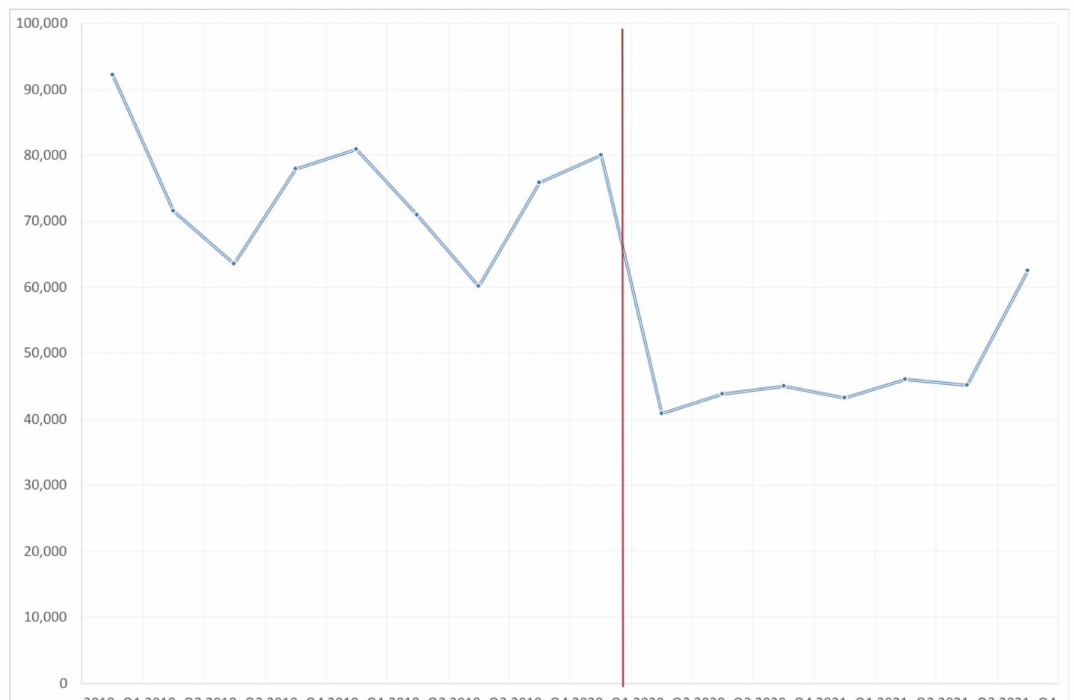
Figure 1. Number of patients treated with systemic antibiotics between the years 2018 and 2021 (year-quarter).